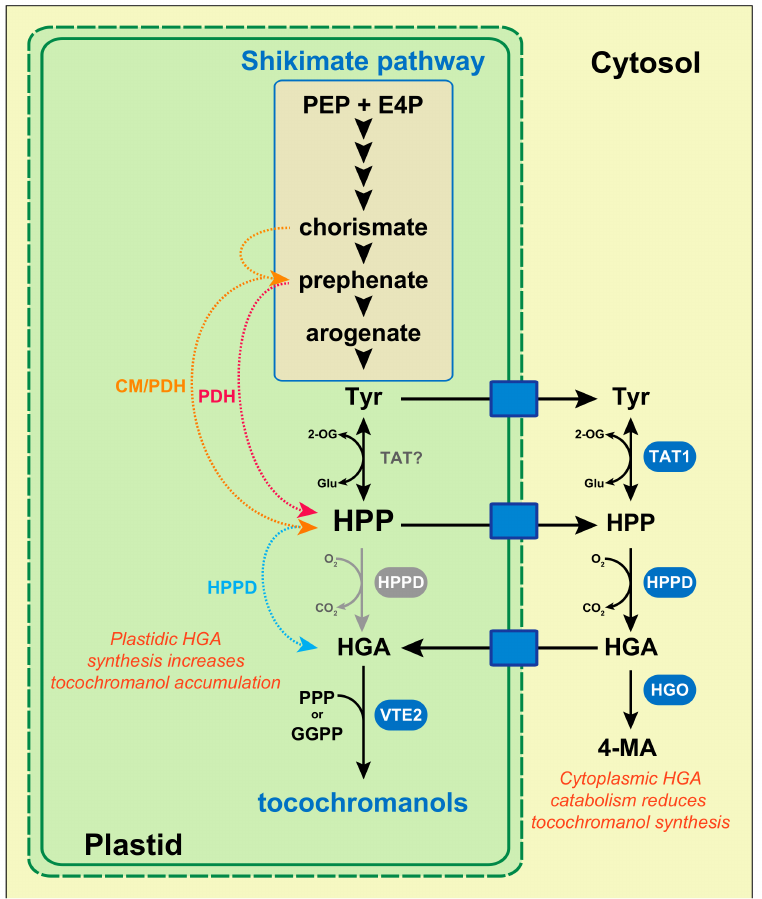
Figure 2. Biosynthesis and transport of homogentisate in plants. Red, orange, and blue dotted lines correspond to transgenic plants overexpressing the coding sequence of yeast PDH , bacterial CM/PDH , and plant HPPD, respectively, all fused to a sequence encoding a chloroplast transit